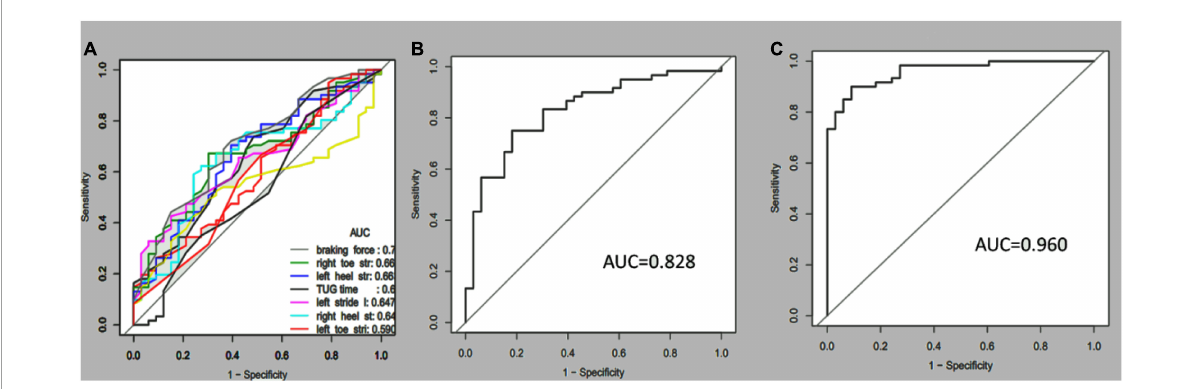
FIGURE2 Receiver-operating characteristic (ROC) curves and corresponding area under the curve (AUC) of the single (A) , multi-kinematic (B) , parameters, and combined multi-kinematic parameters with age, sex, and education (C) to separate amnestic mild cognitive impairment (aMCI) from healthy